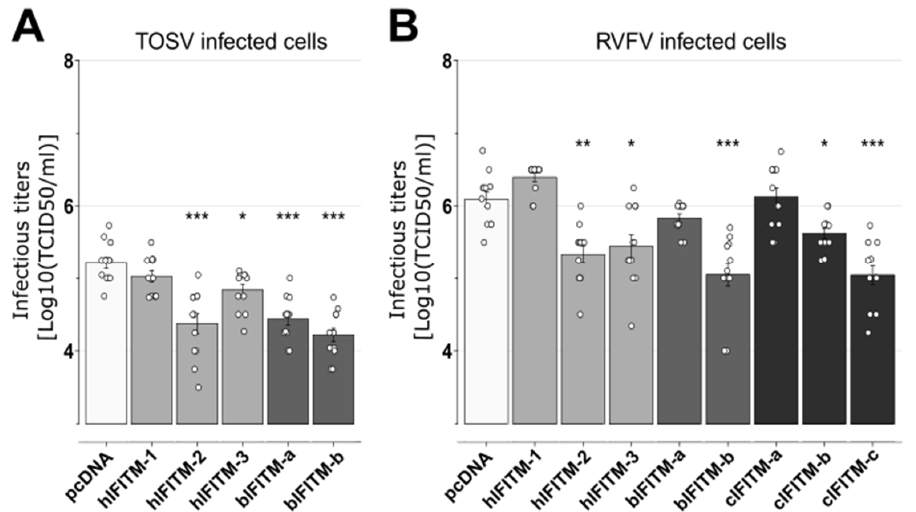
Figure 6. Viral titers of TOSV and RVFV in the presence of human, bovine, or camel IFITMs. Infection assays with TOSV ( A ) or RVFV ( B ) were performed in HEK293T cells expressing or lacking (pcDNA) the different IFITMs, as indicated. At 24 h post-infection, cell supernatants were collected, and viral titers were obtained by limiting-dilution assays in BSR cells. Each experiment was performed in triplicate and at least three times, independently. Bars indicate standard errors. Wilcoxon–Mann–Whitney statistical analyses were performed, and significance (compared to pcDNA data) is presented as follows: p < 0.05 (*), p < 0.01 (**) and p < 0.001 (***). hIFITM-1, human IFITM-1; hIFITM-2,